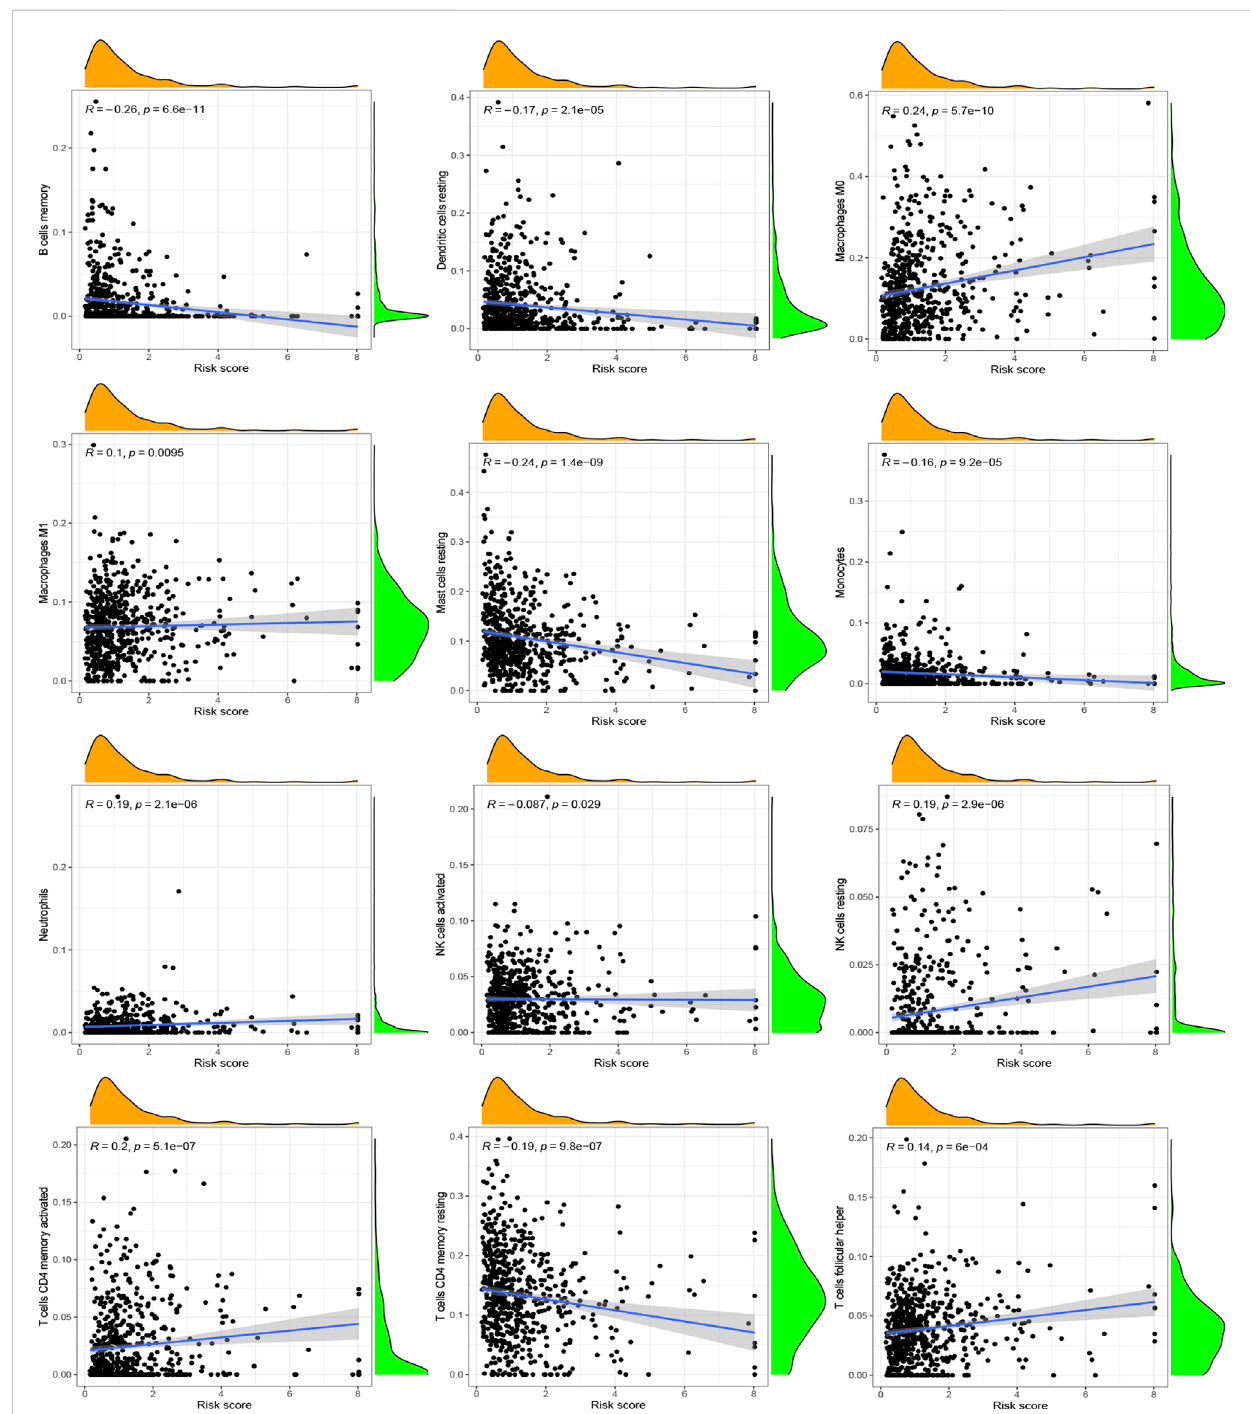
FIGURE 6 Correlation between immune cells and risk scores. Positive correlations: activated memory CD4 T cells, M0 macrophages, M1 macrophages, neutrophils, resting NK cells and follicular helper T cells. Negative correlations: activated mast cells, activated NK cells, memory B cells, monocytes, resting dendritic cells, resting mast cells and resting memory CD4 T cells. p < 0.05 was considered as signi fi cant